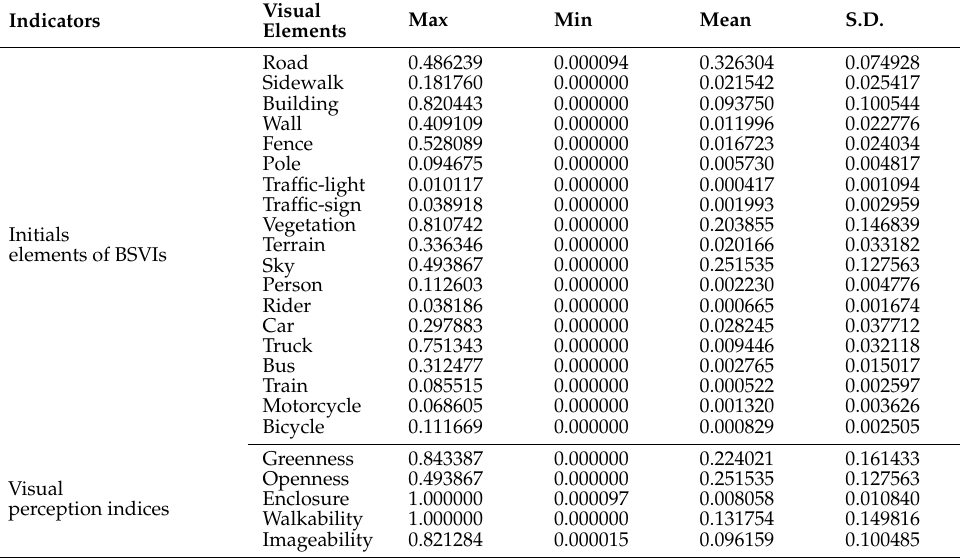
Table 2. Statistics for the segmented results of BSV images